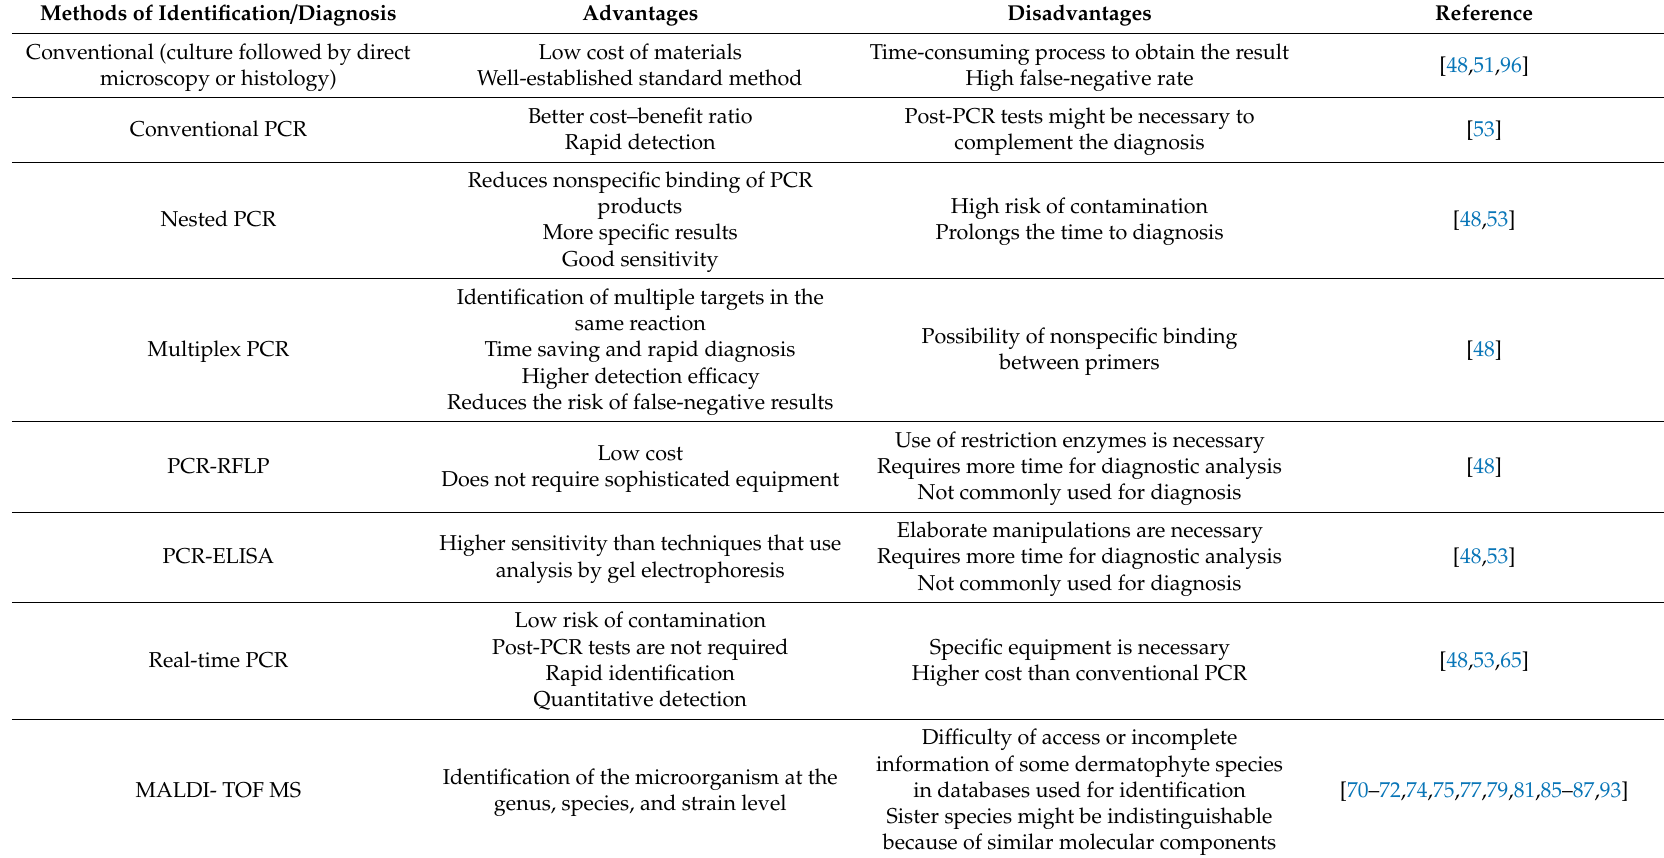
Table 3. Main advantages and disadvantages of the identification and diagnostic methods used for